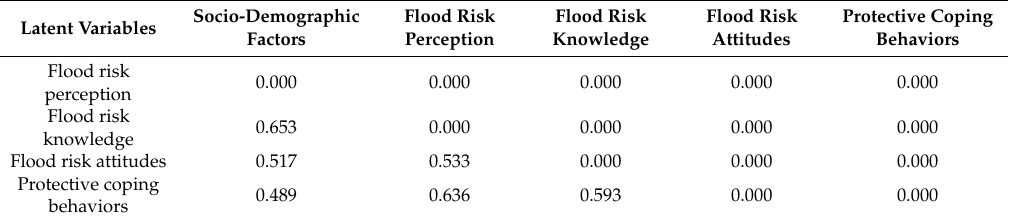
Table 5. Results of standardized indirect e ff ects in SEM.